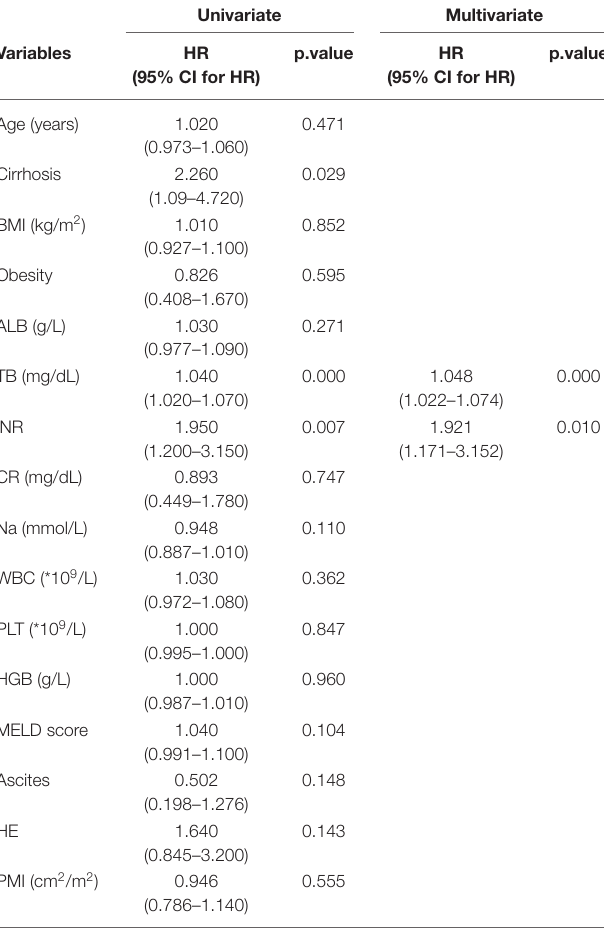
TABLE 4 | Univariate and multivariate Cox regression models in non-young (age > 40 years) male ACLF patients. Univariate